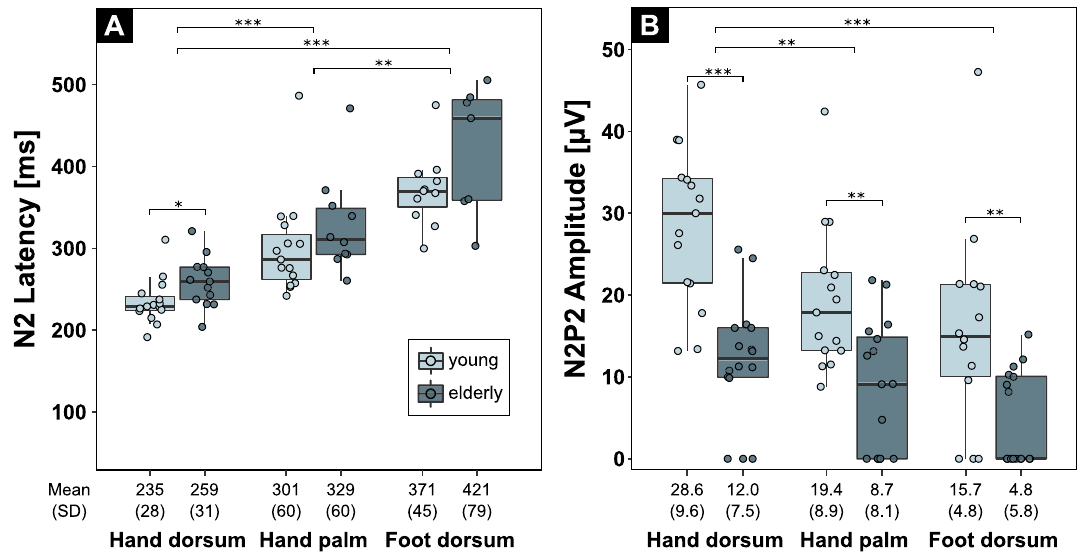
Figure 2. Comparison of cold evoked potential parameters between stimulation sites and age groups. The differences in N2 latencies (A) and N2P2 amplitudes (B) between the three stimulation sites (i.e., hand dorsum, hand palm, and foot dorsum) are shown for all individuals. The differences in CEP parameters between the young and elderly group are shown for each stimulation site. Statistical significance: **p < .01; ***p < .001.